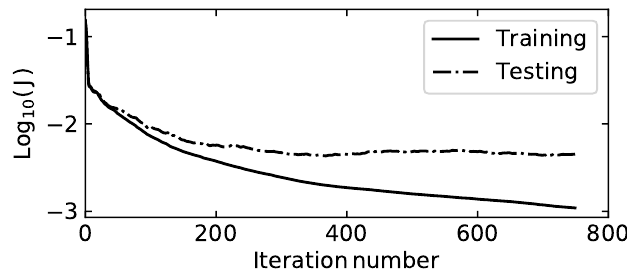
Figure A1. Plot of cost function